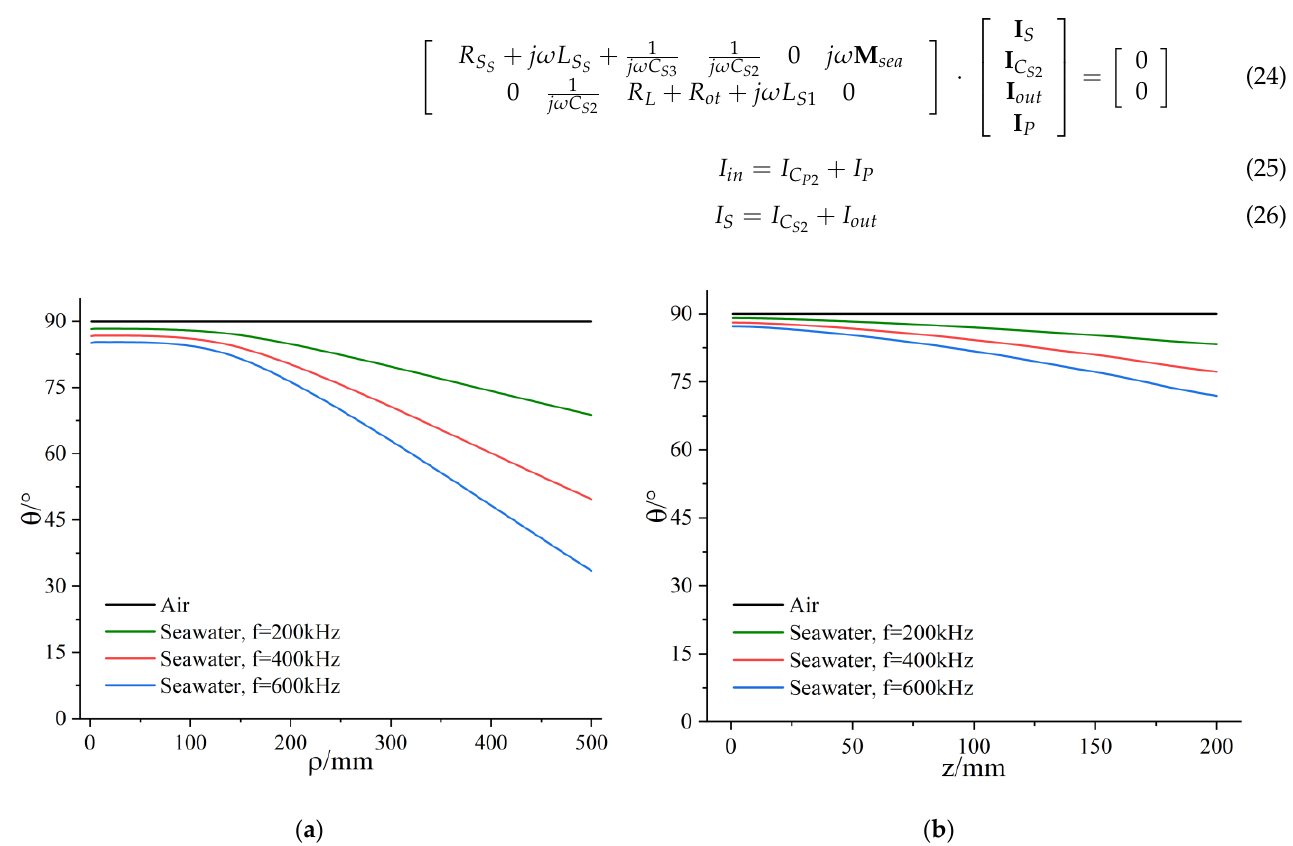
Figure 8. Phase of electric field intensity generated by planar coil in the ( a ) radial direction ( b ) axial direction.